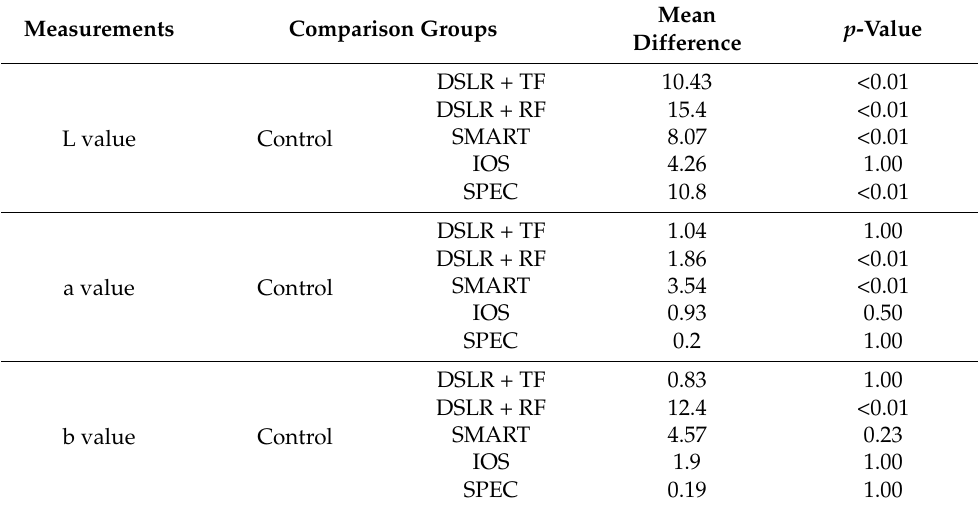
Table 7. The accuracy: Kruskal–Wallis test of CIE Lab values between 5 test groups and control groups. Measurements Comparison